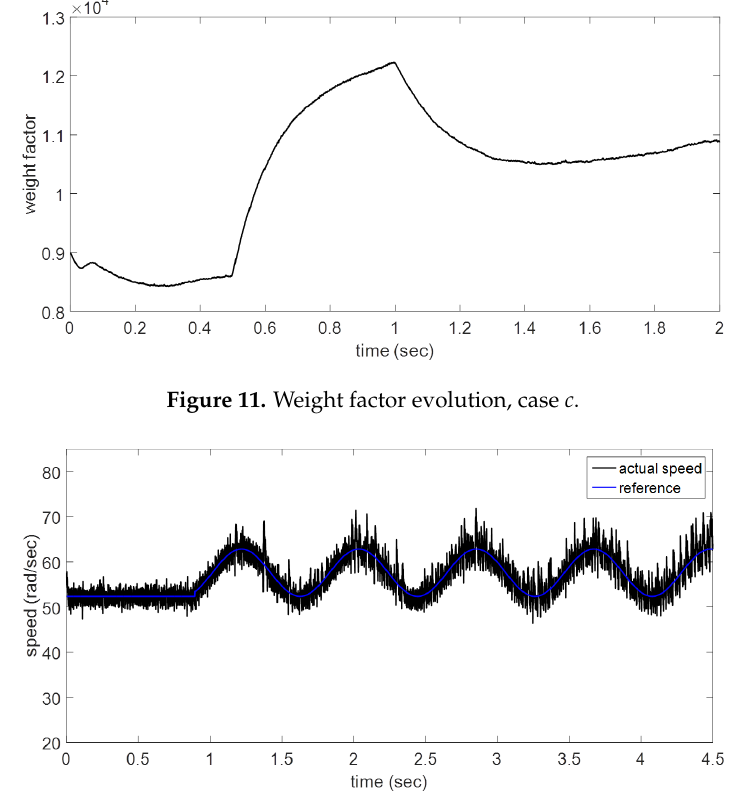
Figure 12. Rotor speed performance for reference tracking, case d .